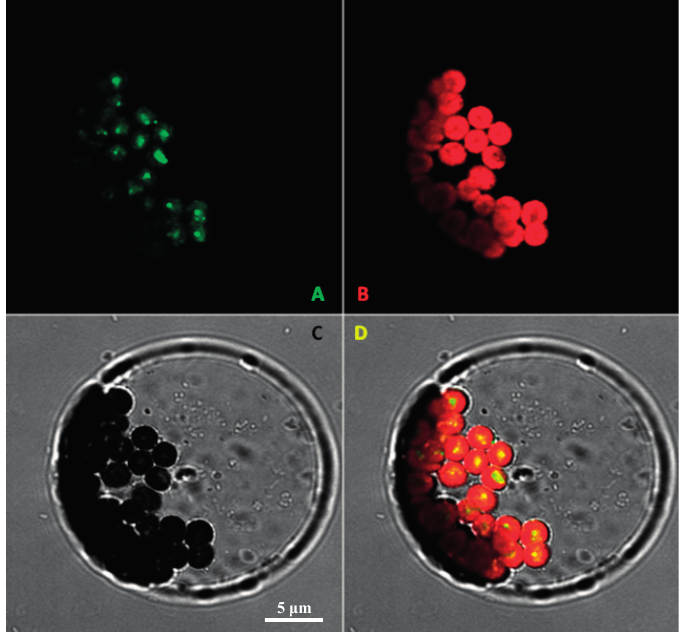
Figure 4. Confocal laser scanning microscopy of transiently expressed VvRiLinNer-GFP fusions in Arabidopsis protoplasts ( A ) Green fluorescent protein fluorescence of VvRiLinNer-GFP; ( B ) Chlorophyll autofluorescence; ( C ) Light-microscopy image of intact protoplast. Bar: 5 μ m; ( D ) Merged images. All images were taken with the 40× water-immersion objectives on the Zeiss LSM 510 (Zeiss,